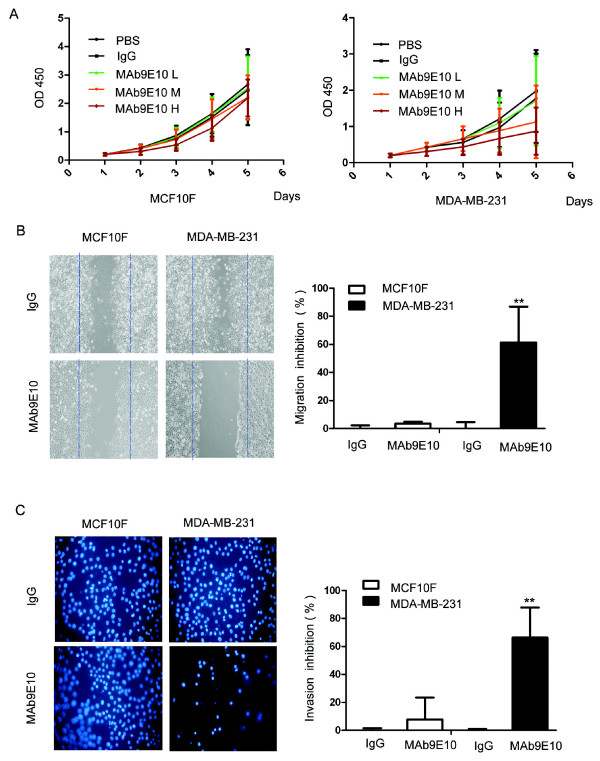
Inhibition of breast cancer cell proliferation, migration and invasion by a functional anti-ATP synthase α- subunit antibody. A , MDA-MB-231 and MCF-10F were plated at a density of 5,000 cells/well in serum-free media for overnight fasting. The α-subunit of ATP synthase was added at concentrations of 10 μg/ml (low dose), 50 μg/ml (medium dose) or 100 μg/ml (high dose). CCK-8 solution was added after 24 h, and the absorbance used to calculate percent proliferation was measured on a Thermo max plate reader at a wavelength of 490 nm. Growth of MDA-MB-231 cells treated with high dose MAb9E10 was significantly suppressed compared with IgG control treatment. MCF-10F cell proliferation was not inhibited by MAb9E10 treatment. B, Migration of MDA-MB-231 and MCF-10F cells were measured using wound-healing assays. MDA-MB-231 cells treated with MAb9E10 100 μg/ml showed lower migration ability comparing with mIgG control; ** P < 0.01. No significant inhibition of migration was observed when MCF-10F cells were treated with MAb9E10. C, Invasion of MDA-MB-231 cells was measured using transwell inserts coated with fibronectin (10 μg/ml). After treatment with anti-ATP synthase α-subunit antibody or control mIgG, cells that migrated through the filters onto the lower surface were fixed, stained and photographed (200×). In each individual experiment, the invaded cells were counted from at least three randomly selected fields. Results were averaged from at least three individual experiments. MDA-MB-231 cells treated with MAb9E10 100 μg/ml also showed lower invasion ability comparing with mIgG control (Figure 5C). Almost no inhibition of invasion when MCF-10F cells treated with MAb9E10. The bar graph displays means ± S.D; ** P < 0.01.